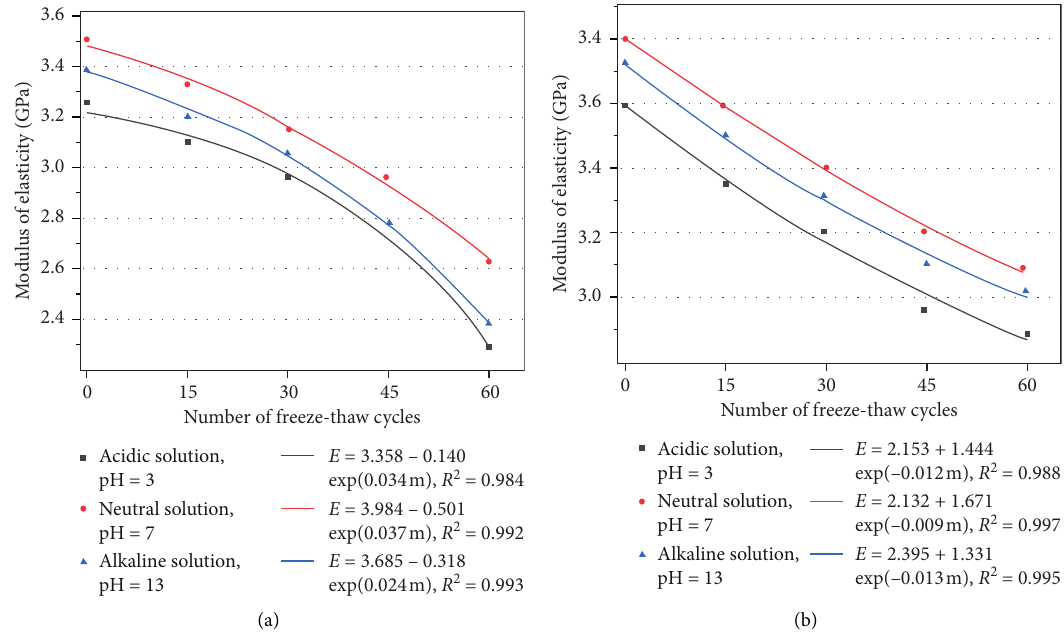
Figure 10: Fitting curves of elastic modulus of sandstone samples and number of freeze-thaw cycles under different chemical erosions: (a) the elastic modulus curves under a confining pressure of 3 MPa; (b) the elastic modulus curves under a confining pressure of 6 MPa. E is the elastic modulus of the samples subjected to m times freeze-thaw cycles under different chemical solution. R 2 is the correlation coefficient.